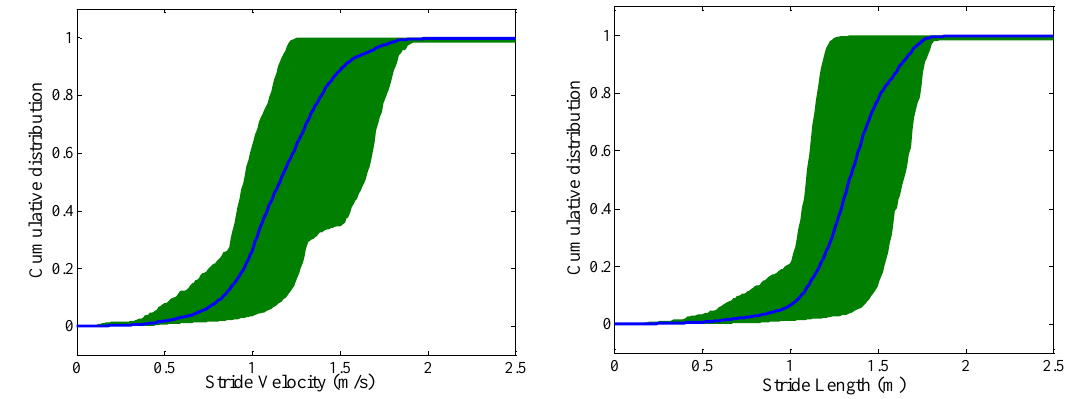
Figure 6. Left : stride velocity distribution; Right : stride length distribution as mean (thick line) and 5th/95th percentile shading across all subjects.